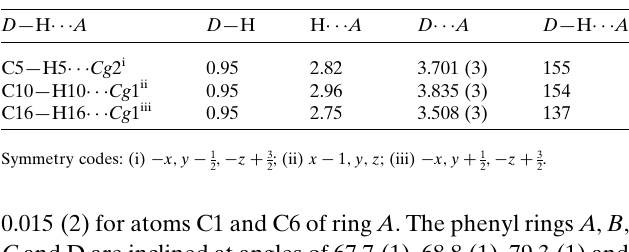
Table 1 Hydrogen-bond geometry (A˚ , (cid:2) ).